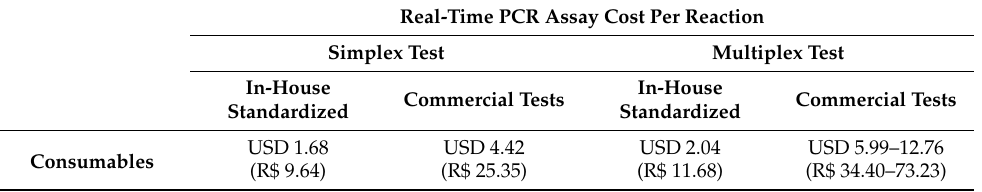
Table 1. Estimated costs related to the consumable reagents and materials for the SMA newborn screening first-tier test (all based on real-time PCR), including the consumables for the DNA extraction step that may differ in the commercial and in-house procedures. These costs do not take into account the second-tier assay. The calculations considered single reactions per sample in a 384-well plate and for 33,521 samples per month (see text for details). Note that some laboratories may choose to perform the test in replicates, according to the results obtained in their validation step.